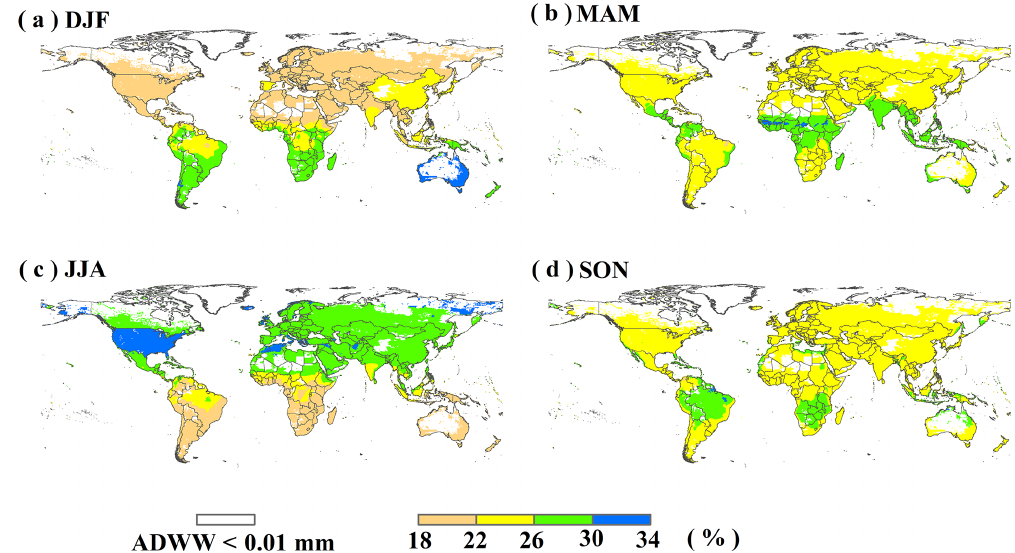
Figure 5. Relative seasonal distribution of global domestic water withdrawal over the period 1971–2010: December to February (DJF), March to May (MAM), June to August (JJA), and September to November (SON), and grids with annual domestic water withdrawal (ADWW) less than 0.01mm are not taken into